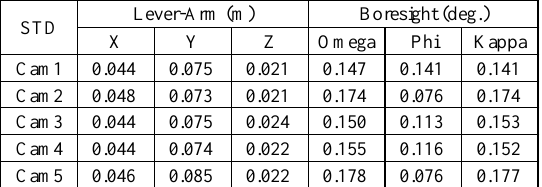
Figure 9: Calibration experiment of MMS cart Table 2: The calibration accuracy of every camera